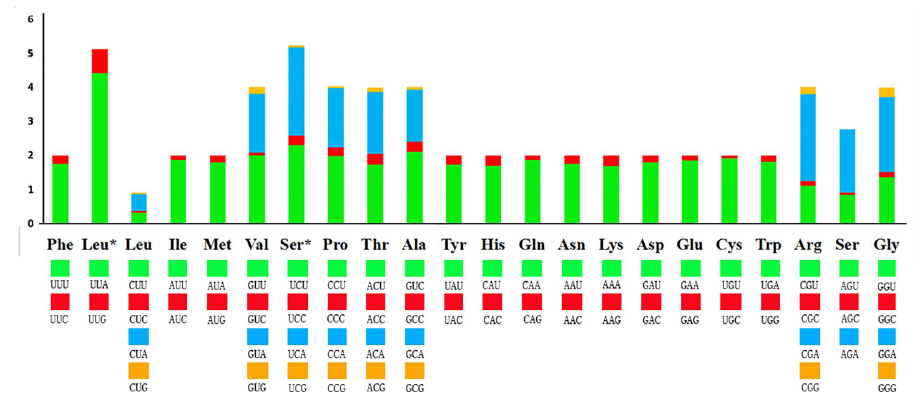
Fig 2. Relative Synonymous Codon Usage (RSCU) in Episymploce splendens mito-genome. A total of 3,711 codons for E . splendens mito-genome were analyzed, excluding stop codons. Leu, Leu � , Ser, and Ser � indicate trnL1 (CUN), trnL2 (UUR), trnS1 (AGN), and trnS2 (UCN), respectively.